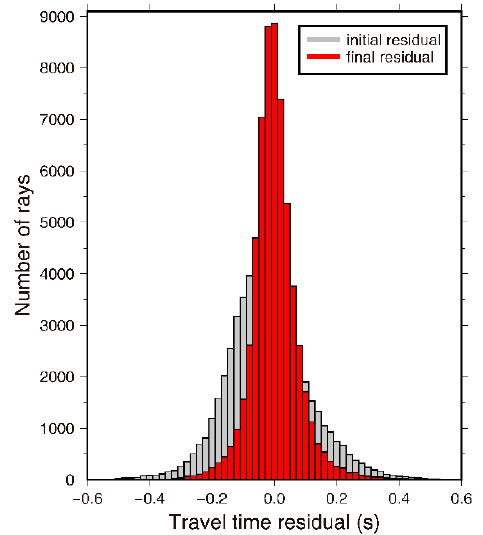
Figure 6. Distributions of surface wave travel-time residuals. Residuals before inversion are gray columns with the average µ = − 0.022 s and the standard deviation σ = 0.197 s. Residuals after inversion are red columns with µ = 0.001 s and σ = 0.076 s.